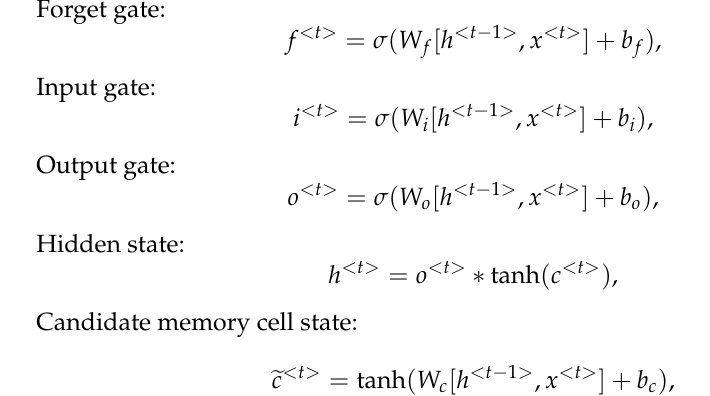
Figure 4. Illustration of gated recurrent unit (GRU) unit, having two gates without dedicated memory cell state. GRU has only two “gates”, called update gate and reset gate. The update gate decides how much of the past information needs to be further passed and which new information to add. The reset gate decides how much of the past information to forget. GRU does not have an additional memory cell and directly uses hidden state to transfer information. The mathematical expressions can be found in the equations below: Update gate: